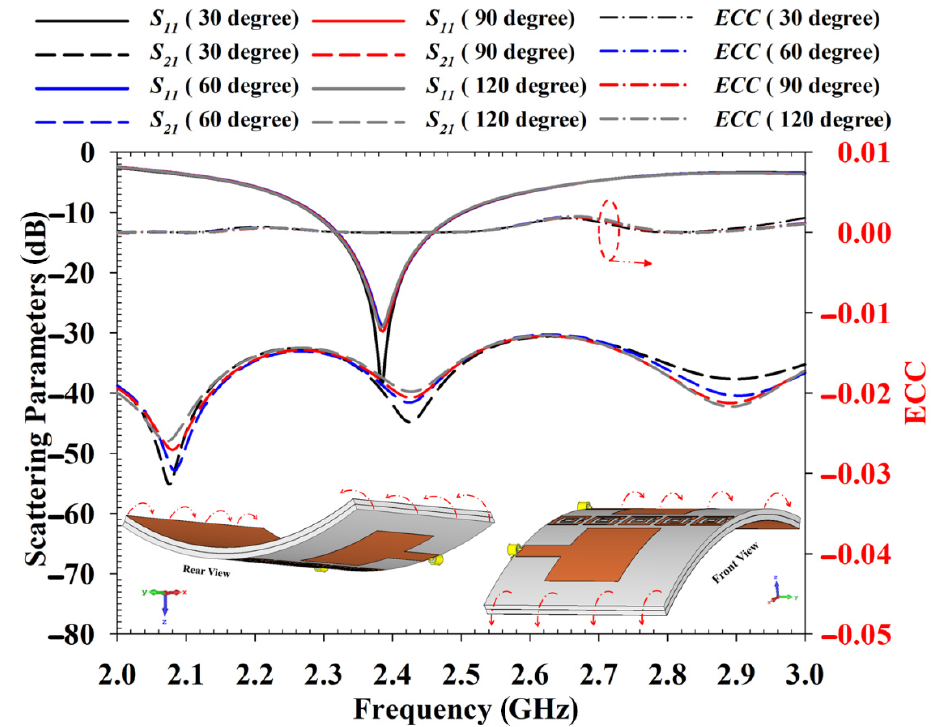
Figure 16. Bending analysis of the antenna at x axis.